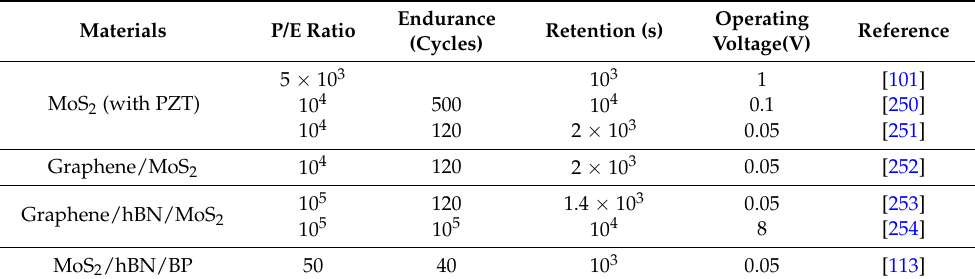
Table 6. Performance of memory devices based on TMDCs and other